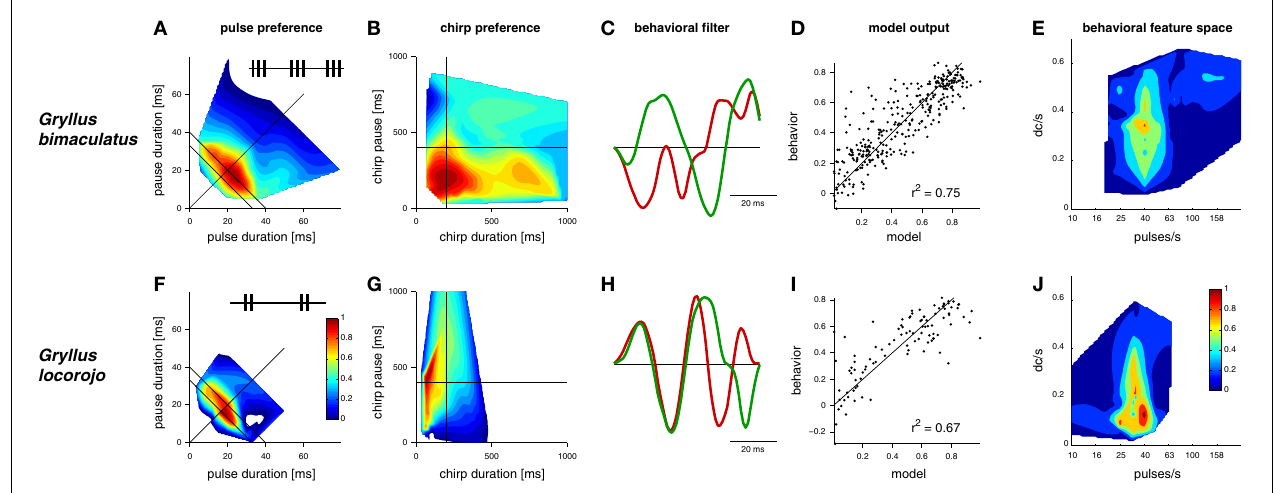
FIGURE 1 | LN-models derived from behavioral preference tests of two Gryllus species for acoustic signals. Preference profiles for (A,F) pulse and (B,G) chirp patterns (insets: schematic song patterns). (C,H) linear filters (filters were scaled to unit-norm and have no units) (D,I) model output predicts behavior, units refer to the attractiveness of test patterns from